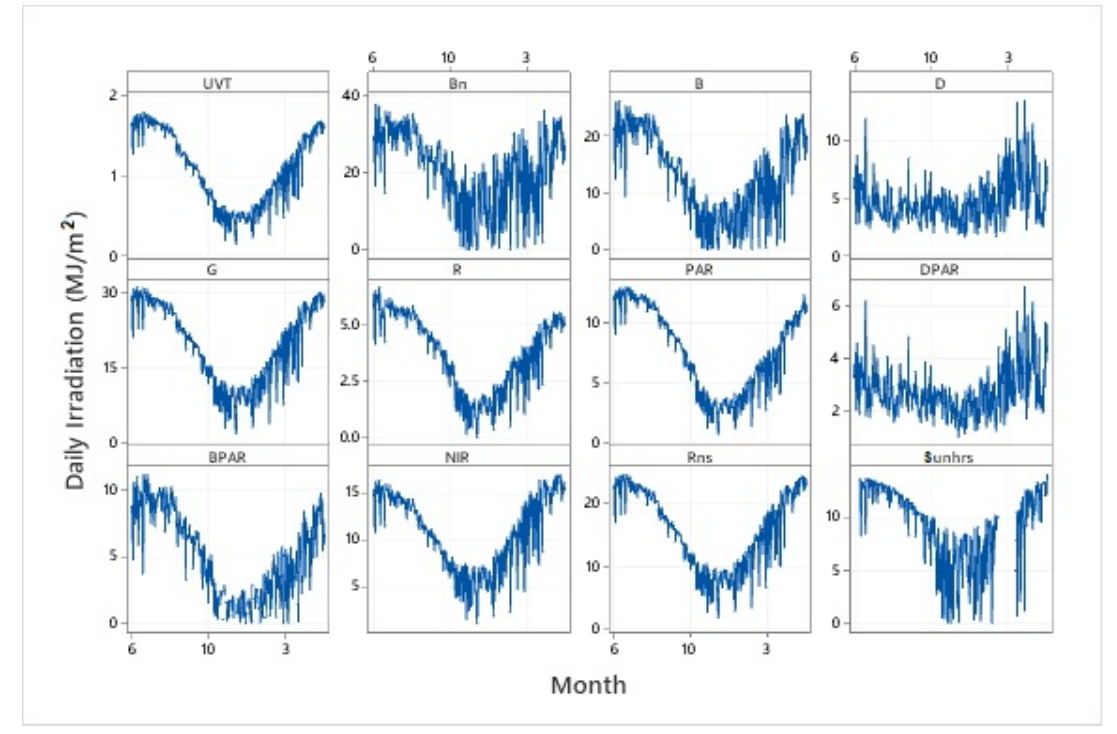
Figure 14. Time series plots of daily values of all shortwave radiation components including daily sunshine duration.